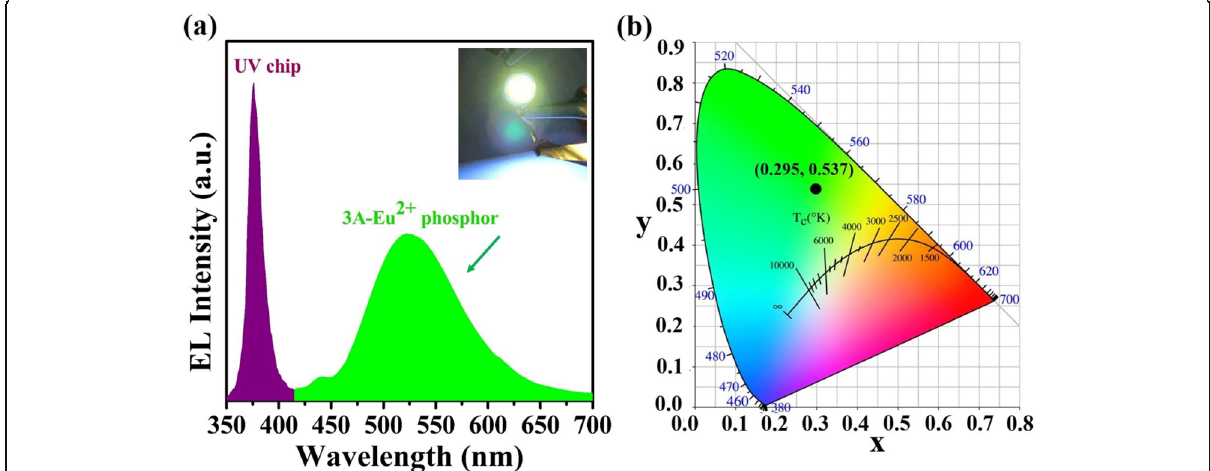
Fig. 6 a Electroluminescence emission spectrum at 3 V voltage for zeolite-3A: 1.3 wt% Eu phosphor sintered at 1400 °C for 3 h, and the inset is a photograph of working green LED at 3 V voltage. b Color coordinate in the CIE1931